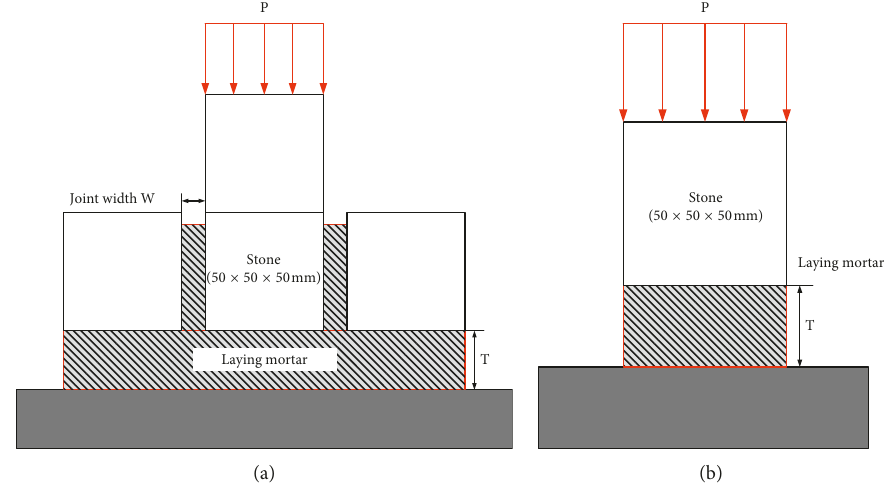
Figure 6: Vertical cross section of the test setup. (a) Fully restrained and semirestrained. (b) Nonrestrained.